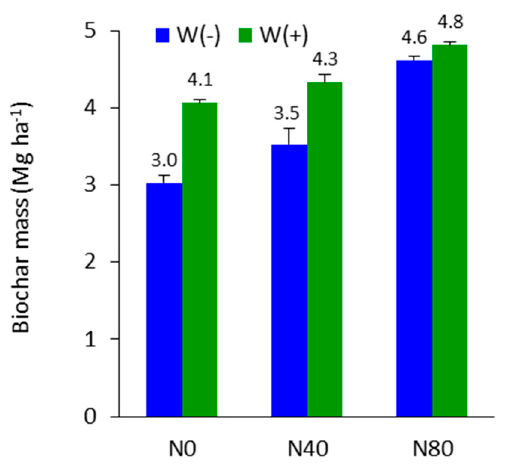
Figure 7. Biochar mass after gasification process.